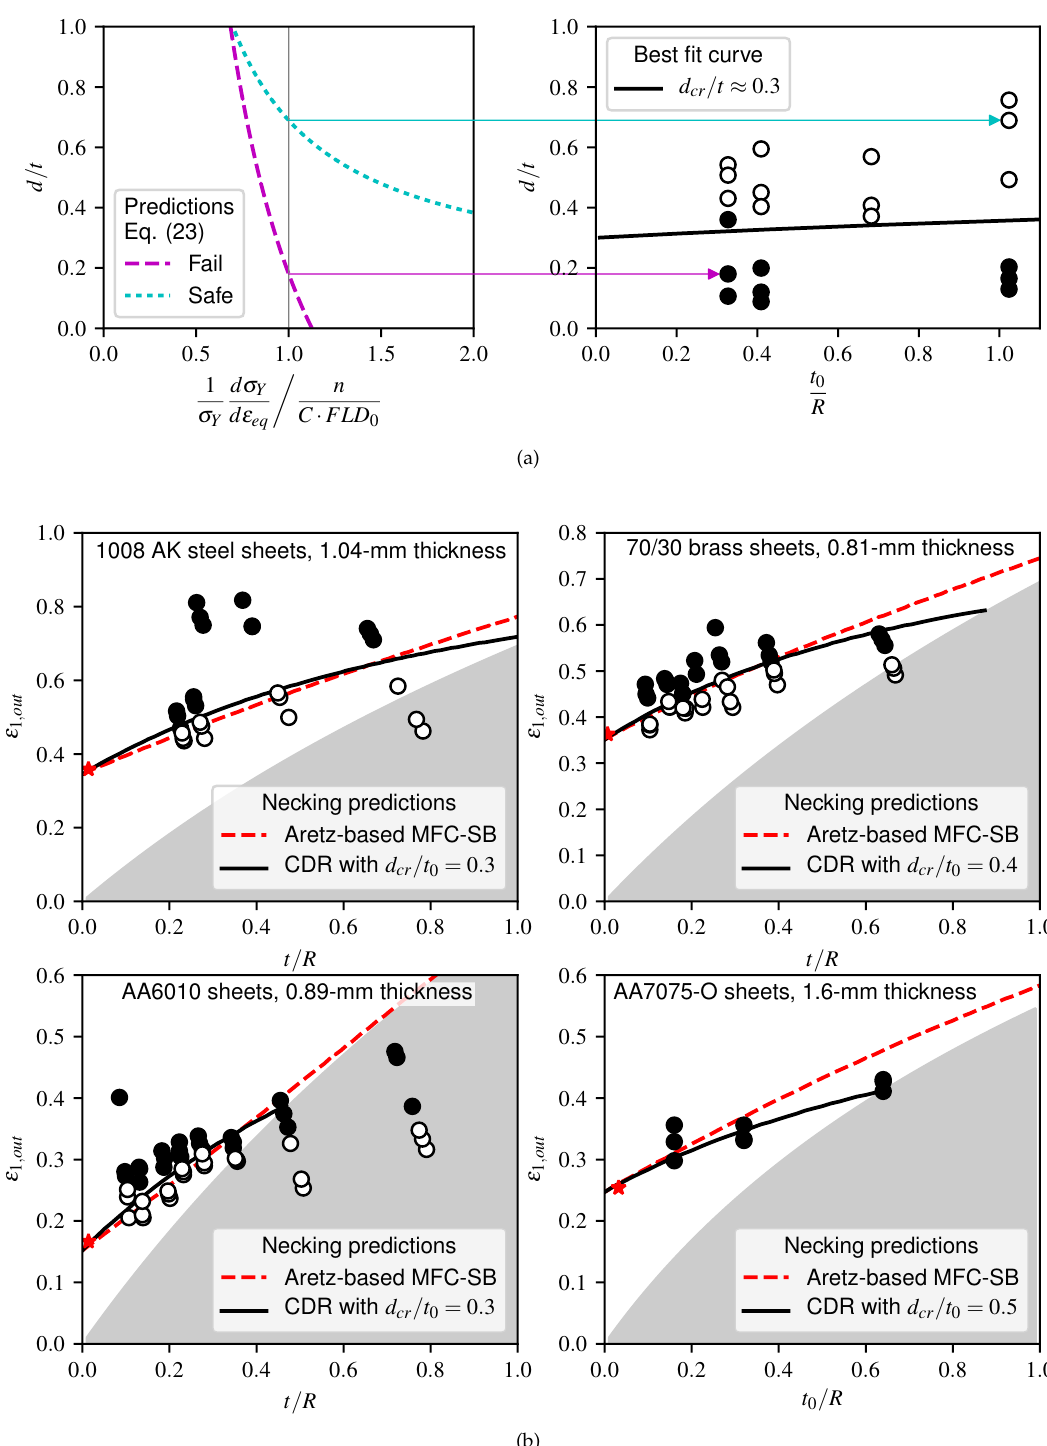
Figure 7. Practical application of the proposed critical-distance rule (CDR) criterion. ( a ) Graphical representation for the calibration of the CDR (Equation (34)) for 1008 AK steel sheets: (left) predictions of the non-dimensional strain-hardening characteristic through the sheet thickness by Equation (23), illustrated for the experimental data of a failed and a successful specimen; (right) graphical determination of the critical distance as an almost horizontal line that separates failed from successful tests. ( b ) Necking predictions of proposed Aretz-based maximum force criterion in stretch bending (MFC-SB; Equation (28)) and CDR criterion (Equation (34)) for stretch-bent 1008 AK steel, 70/30 brass, AA6010 and AA7075-O